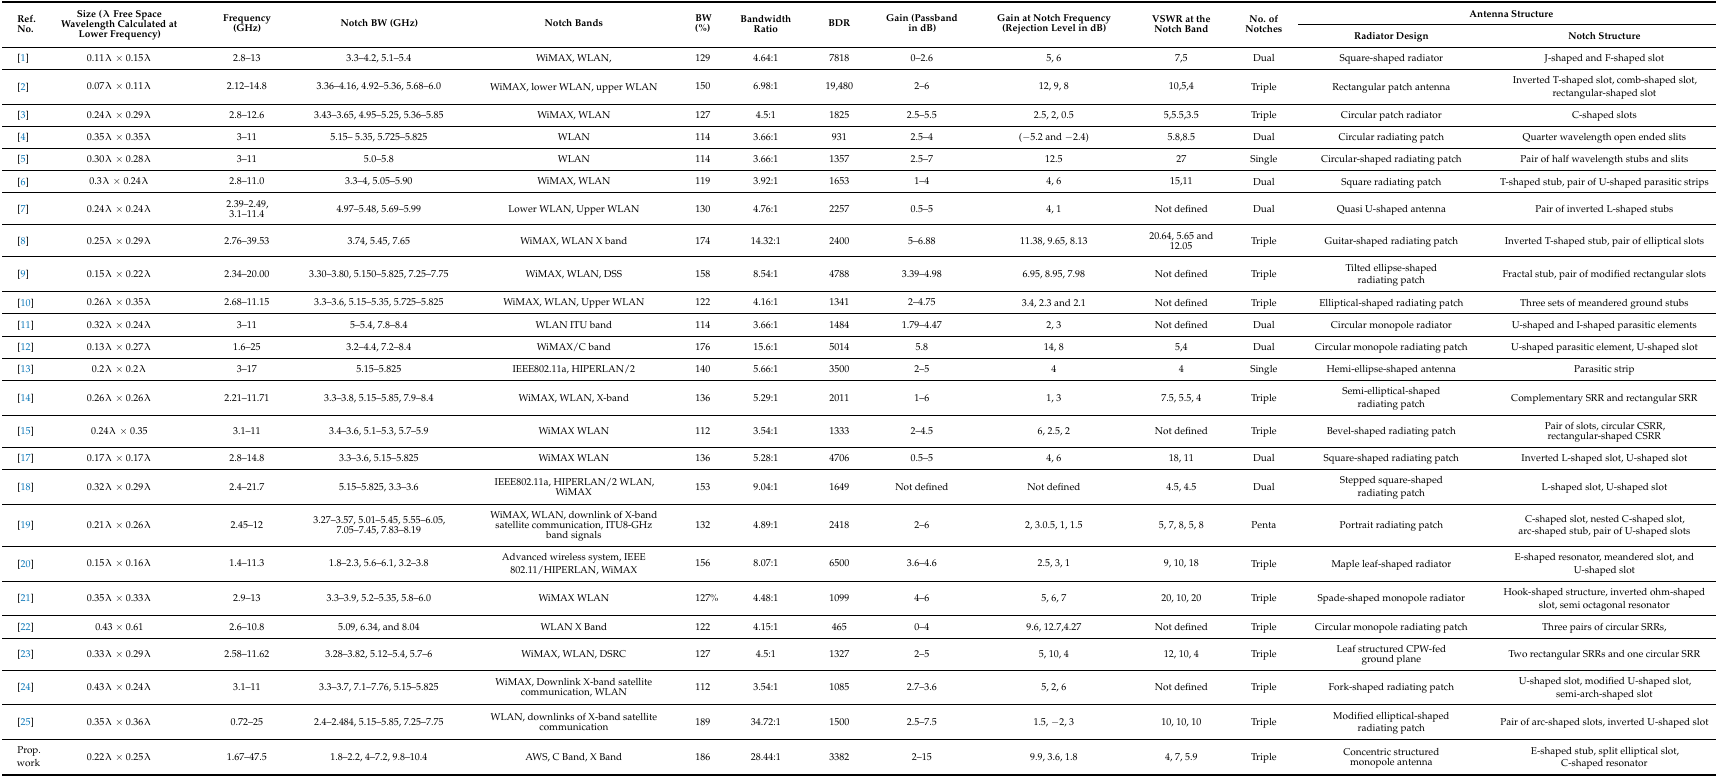
Table 3. Comparison of proposed design with existing